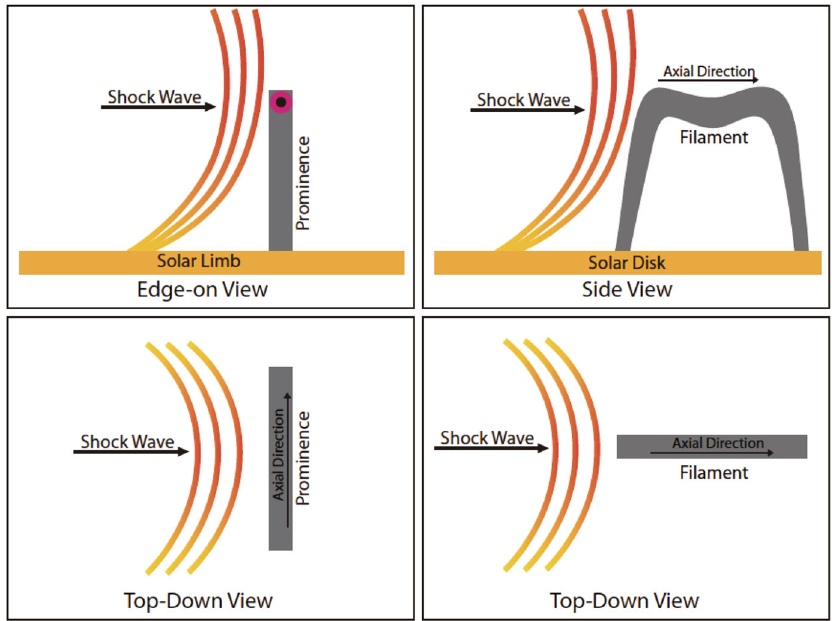
Fig. 5 Cartoon showing the wave-prominence and wave-filament interaction processes triggering trans- verse and longitudinal oscillations, respectively. Image reproduced with permission from Shen et al. (2014b), copyright by